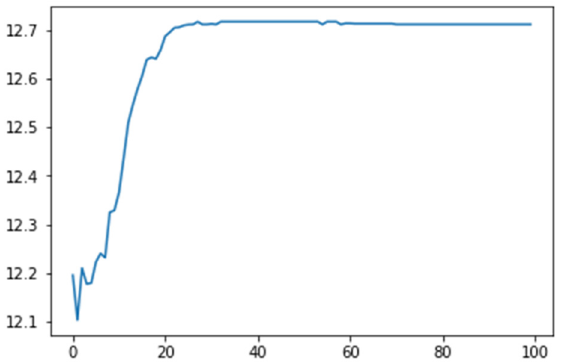
Figure 11. Iteration diagram of the GA model.